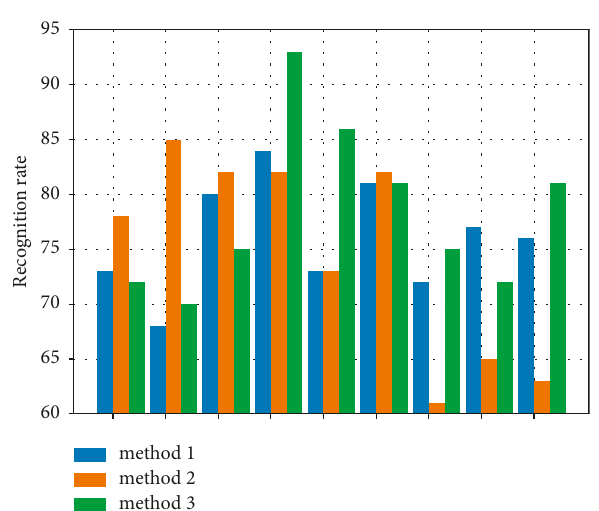
Figure 5: Platform test results.